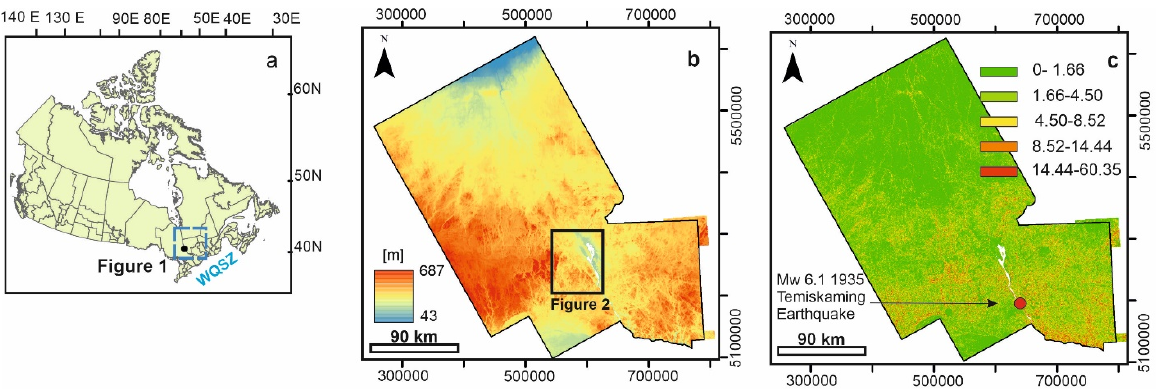
Figure 1. ( a ) Location of the study area within the eastern Canada, showing a broad outline of the WQSZ and the location of where our study area is located; ( b ) DEM of the study area between the provinces of Ontario and Quebec; ( c ) slope map of the study area, calculated in percent rise and location of the Mw 6.1 1935 Temiskaming earthquake (source: seismescanada.rncan.gc.ca, accessed on 1 September 2021).